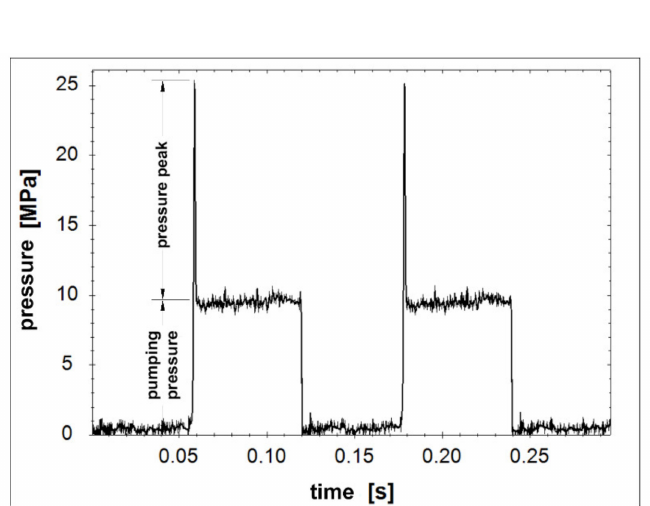
Figure 5. Sample characteristics of the pressure changes inside the working chamber and pressure peak definition [12].